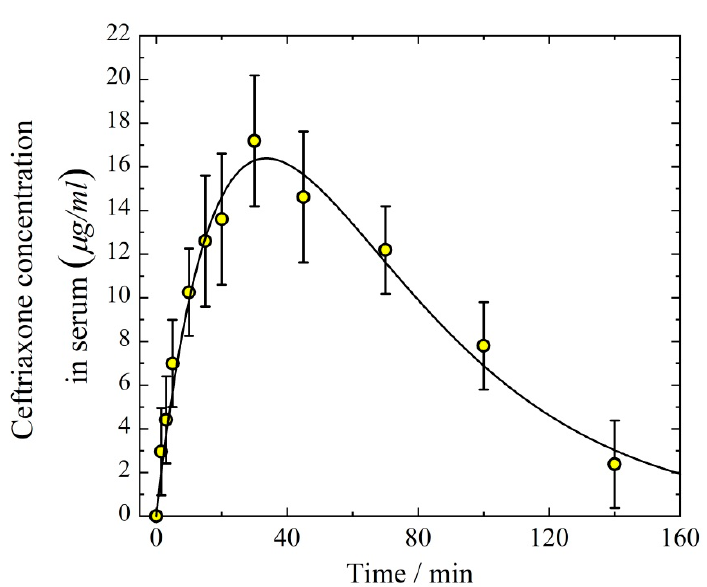
Figure 7. Temporal dependence of the concentration of ceftriaxone in serum after intraperitoneal injection with the dose of 5 mg/kg. The solid line follows Equation (10).